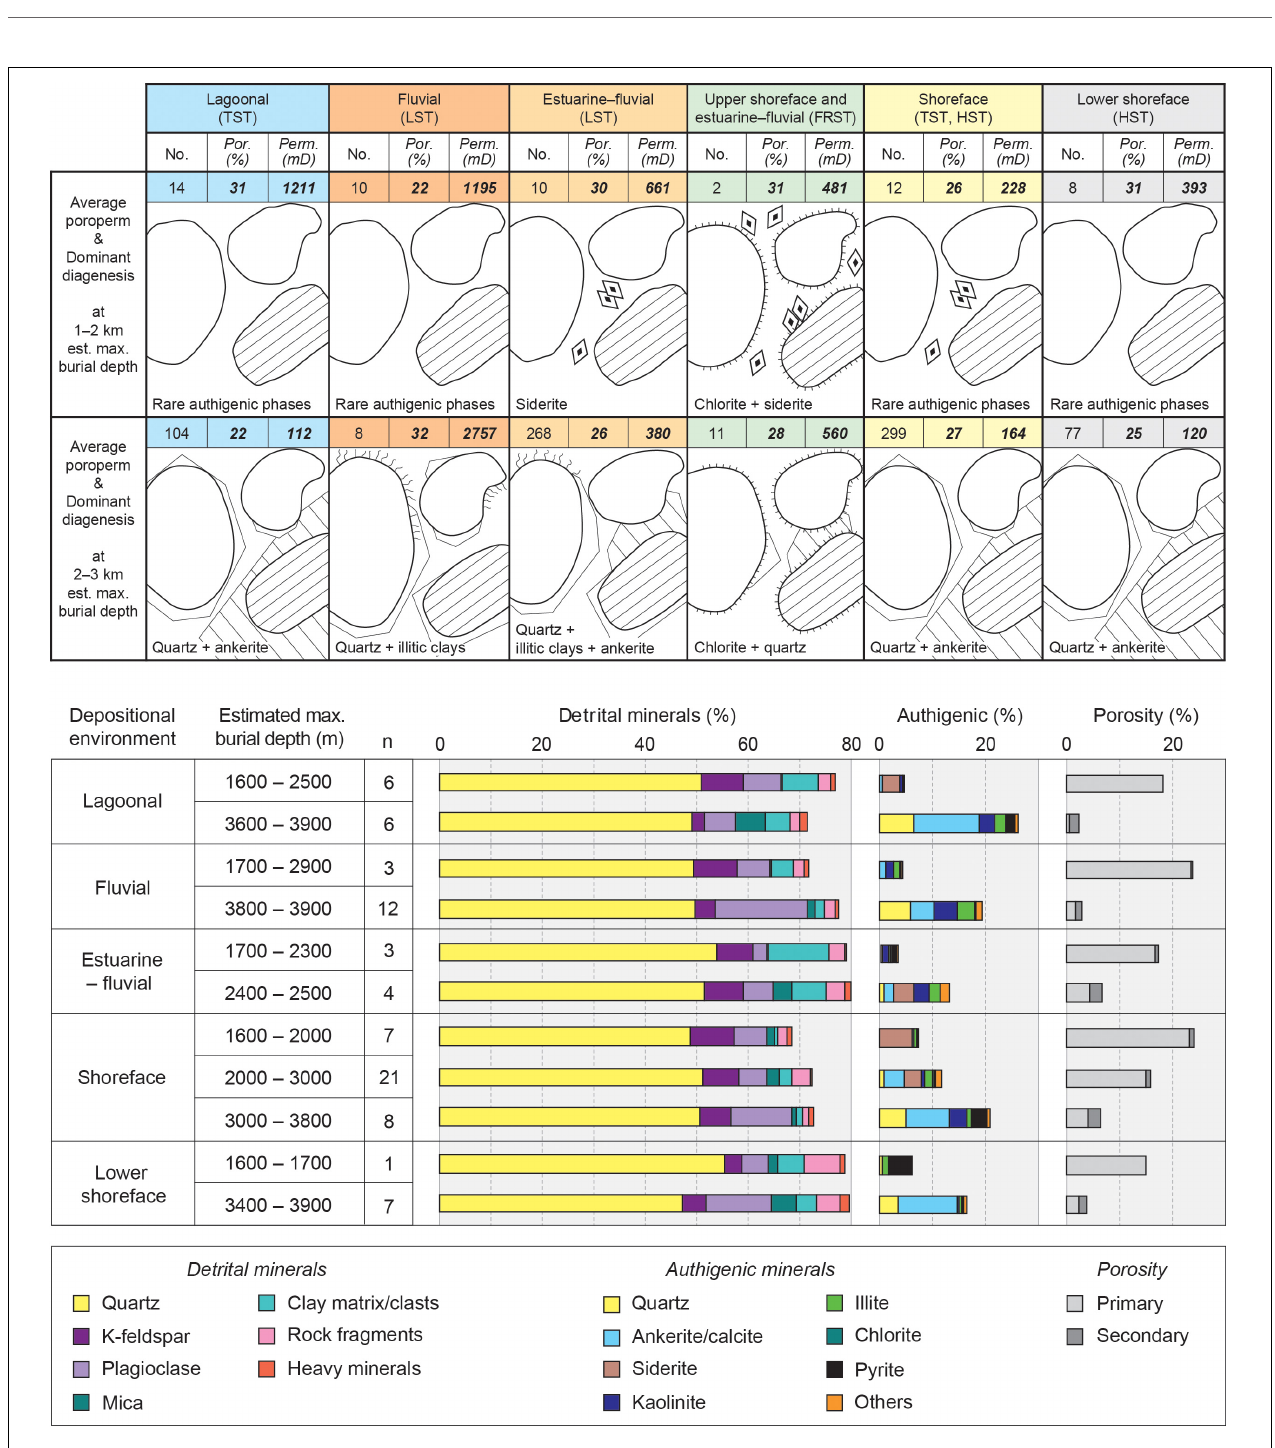
FIGURE 13 | Overview of the typical diagenetic alterations occurring in the different depositional environments and the resulting average porosity and permeability for estimated maximum burial depths of sandstones from the Gassum Formation onshore Denmark. The mineralogy is quantified by petrographic point counting. Modified from Weibel et al. (2017a). TST, transgressive systems tract; LST, lowstand systems tract; FRST, forced regressive systems tract; HST, highstand systems